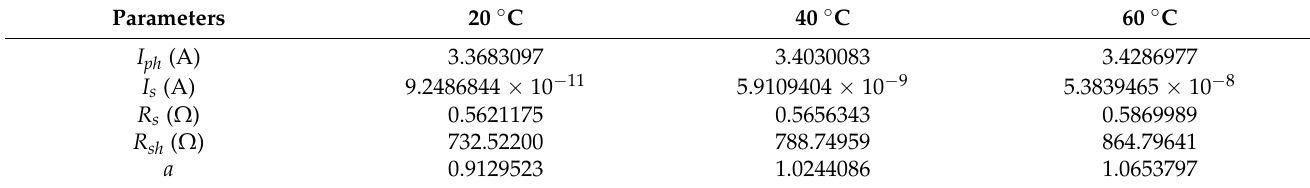
Figure 12. Absolute errors of I-V characteristics between symbols and lines in Figure 10. Table 6. Parameter estimation values for I- and P-V characteristics in Figures 10 and 11.